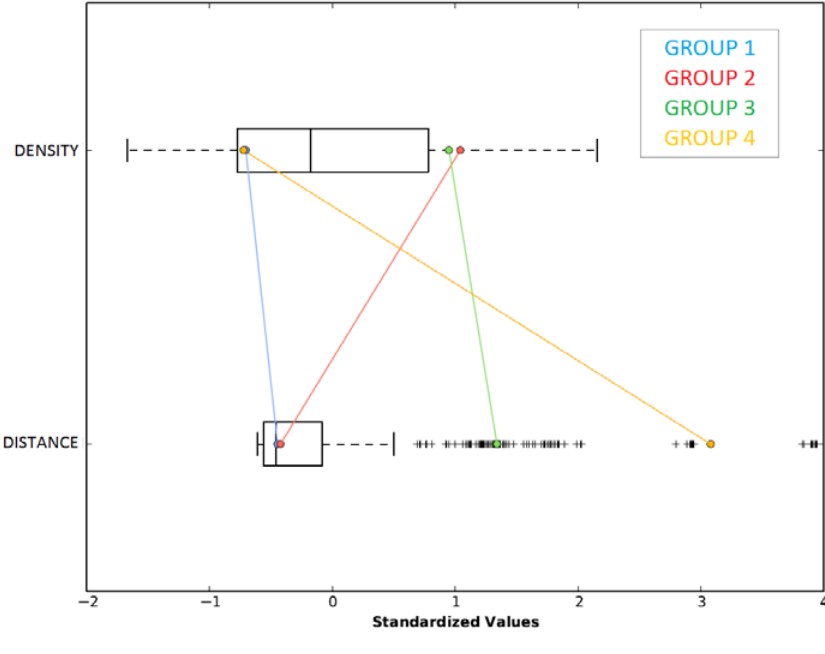
Figure 1: The Parallel Box Plot of the grouping